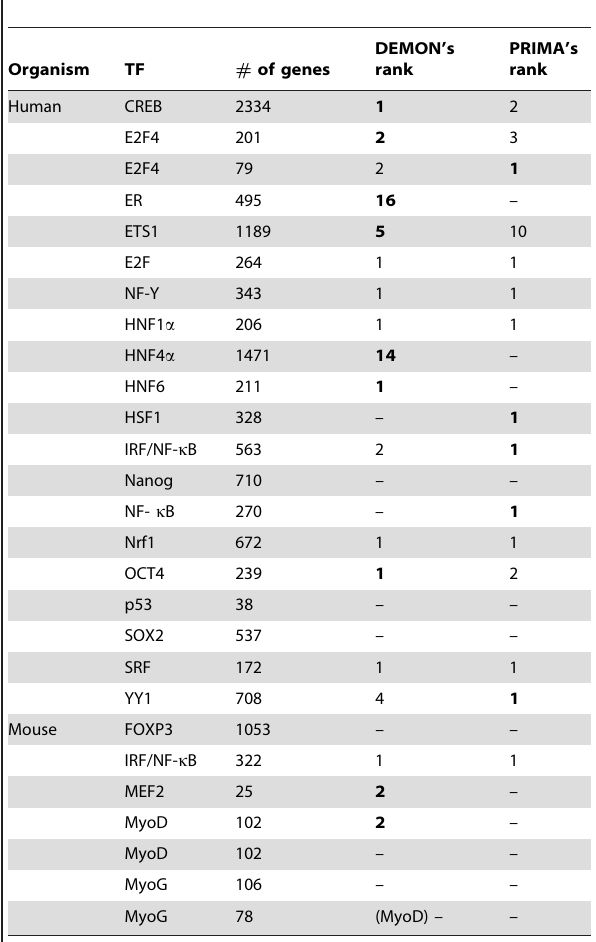
Table 1. DEMON and PRIMA results on the Amadeus metazoan